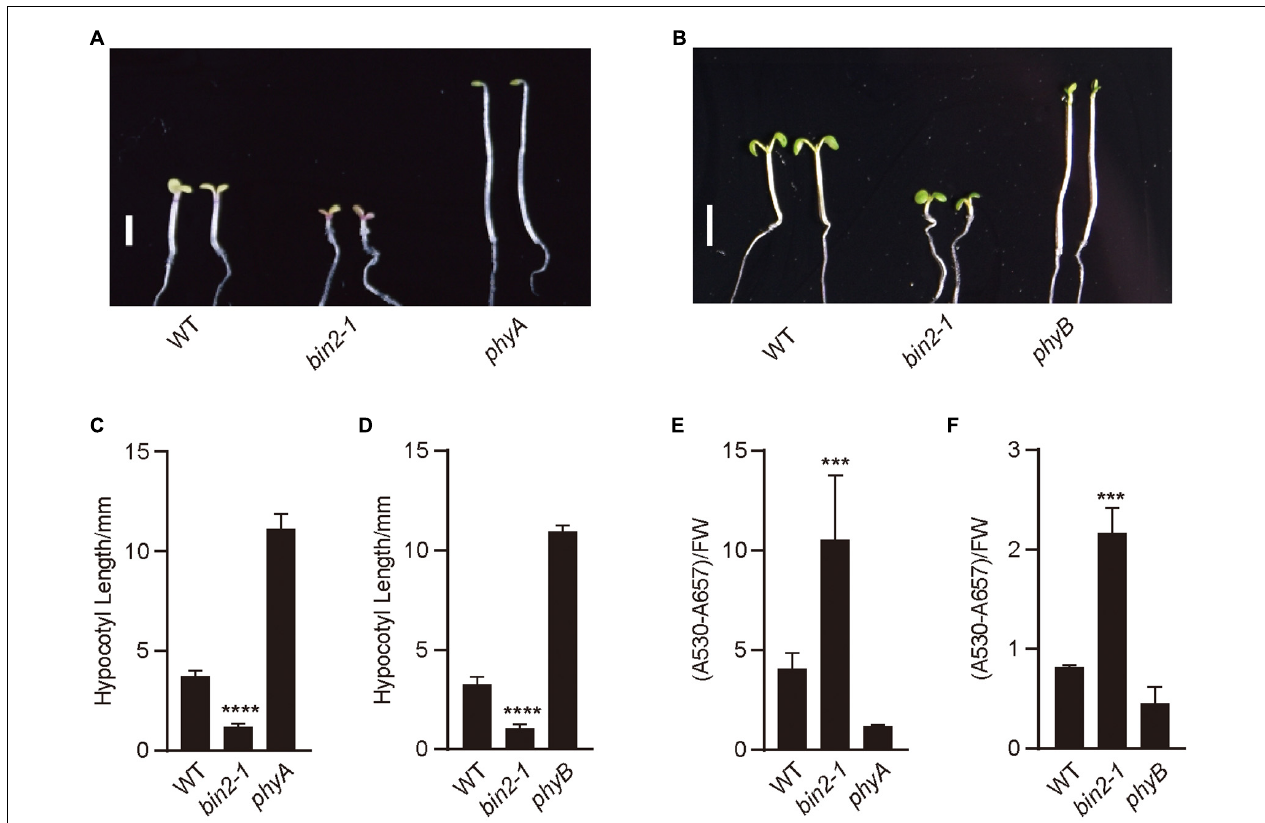
FIGURE 2 | BIN2 acts to promote photomorphogenesis in red and far-red lights. (A,B) These genotypes of seedlings were grown under continuous far-red light (1 µ mol/m 2 /s) (A) and red light (50 µ mol/m 2 /s) (B) for 5 days, respectively. Scale bars, 2 mm. (C,D) Statistical analyses of hypocotyl lengths made from the genotypes of seedlings shown in (A,B) . Data are represented as mean ± SD ( n ≥ 20). (Student’s t -test, ****P < 0.0001). (E,F) Anthocyanin contents analyses of the genotypes of seedlings shown in (A,B) . Data are represented as mean ± SD ( n = 2). (Student’s t -test, ***P < 0.001).